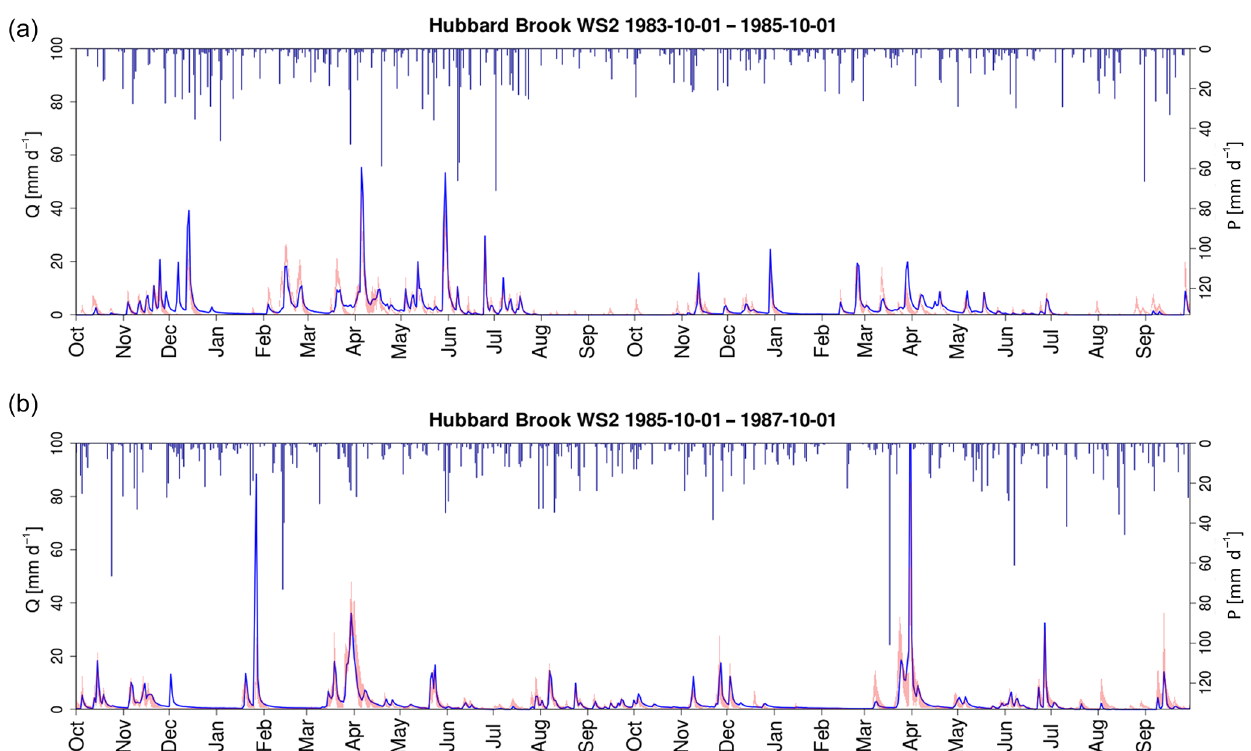
Figure 6. Observed and modelled hydrograph for Hubbard Brook WS2 for (a) the years of 1984 and 1985 and (b) the years of 1986 and 1987, with the red coloured area indicating the 5 / 95% uncertainty intervals of the modelled discharge. Blue bars show daily